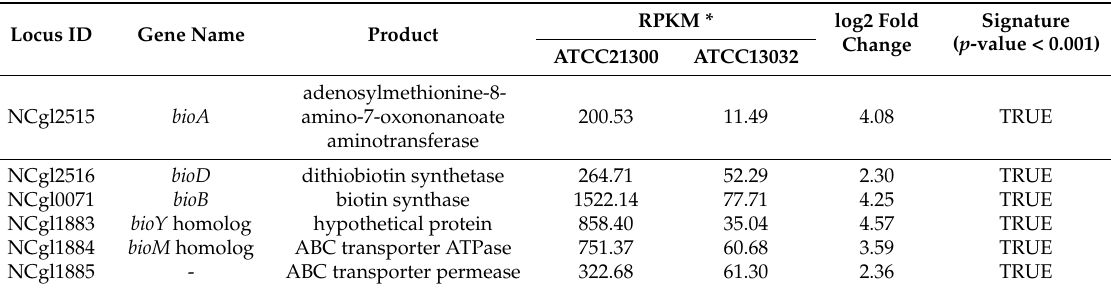
Table 1. Expression patterns of genes involved in biotin metabolism in Corynebacterium glutamicum ATCC13032 and ATCC21300.